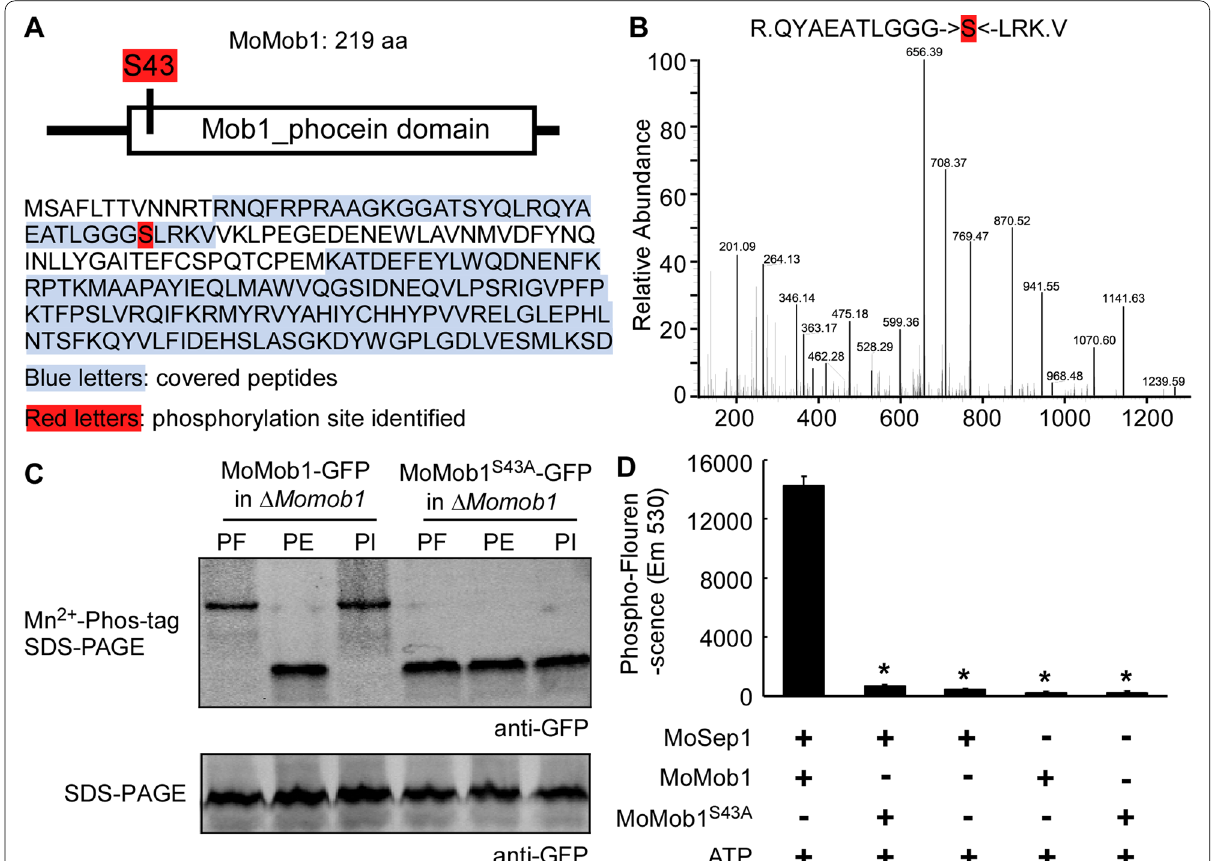
Fig. 3 S43 of MoMob1 is the key phosphorylation site by MoSep1. A Comparison of MoMob1 phosphorylation sites in Guy11 and the Δ Mosep1 mutant identified by LC-MS/MS analysis. B MoMob1 phosphorylation sites in Guy11 compared with the Δ Mosep1 mutant expressing MoMOB1 identified by LC-MS/MS analysis. C In vivo phosphorylation analysis of MoMob1 in the Δ Momob1/MoMOB1 S43A and Δ Momob1/MoMOB1 strains. MoMob1-GFP proteins treated with phenylmethylsulfonyl f﻿luorid (PF), phosphatase (PE) and phosphatase inhibitors (PI), and detected by the anti-GFP antibody. The phosphorylated-MoMob1 band is higher than controls when detected in the Mn 2 + -Phos-tag SDS-PAGE gel. D In vitro phosphorylation analysis by the f﻿luorescence detection in tube (FDIT) method. Purified proteins of His-MoMob1, His-MoMob1 S43A , and His-MoSep1 were used for kinase reactions in the presence of 50 μm ATP and dyed with the Pro-Q Diamond Phosphorylation Gel Stain. The f﻿luorescence signal at 590 nm (excited at 530 nm) was measured in a Cytation3 microplate reader (Biotek, Winooski, VT, USA). Error bars represent the standard deviations from three independent experiments. Asterisks indicate statistical significance according to a Student’s test ( p <